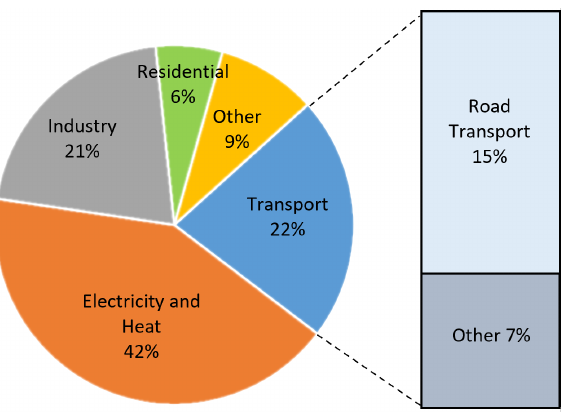
Figure 1. Total CO 2 emissions of different sectors and the portion of road transport [1].